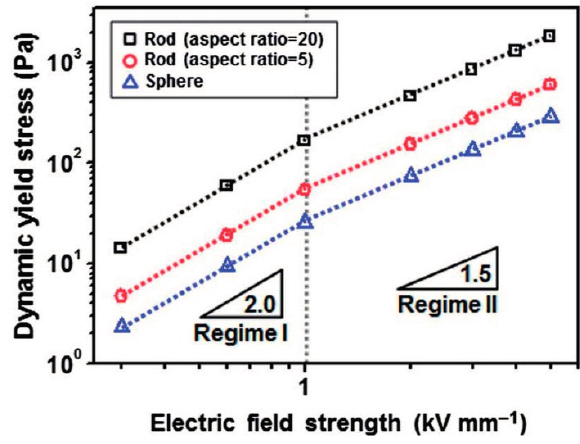
Figure 3. The comparison of dynamic yield stress of GO-wrapped silica particles based ER fluids with different aspect ratio (Reprinted with permission from [81], copyright 2014 Royal Society of